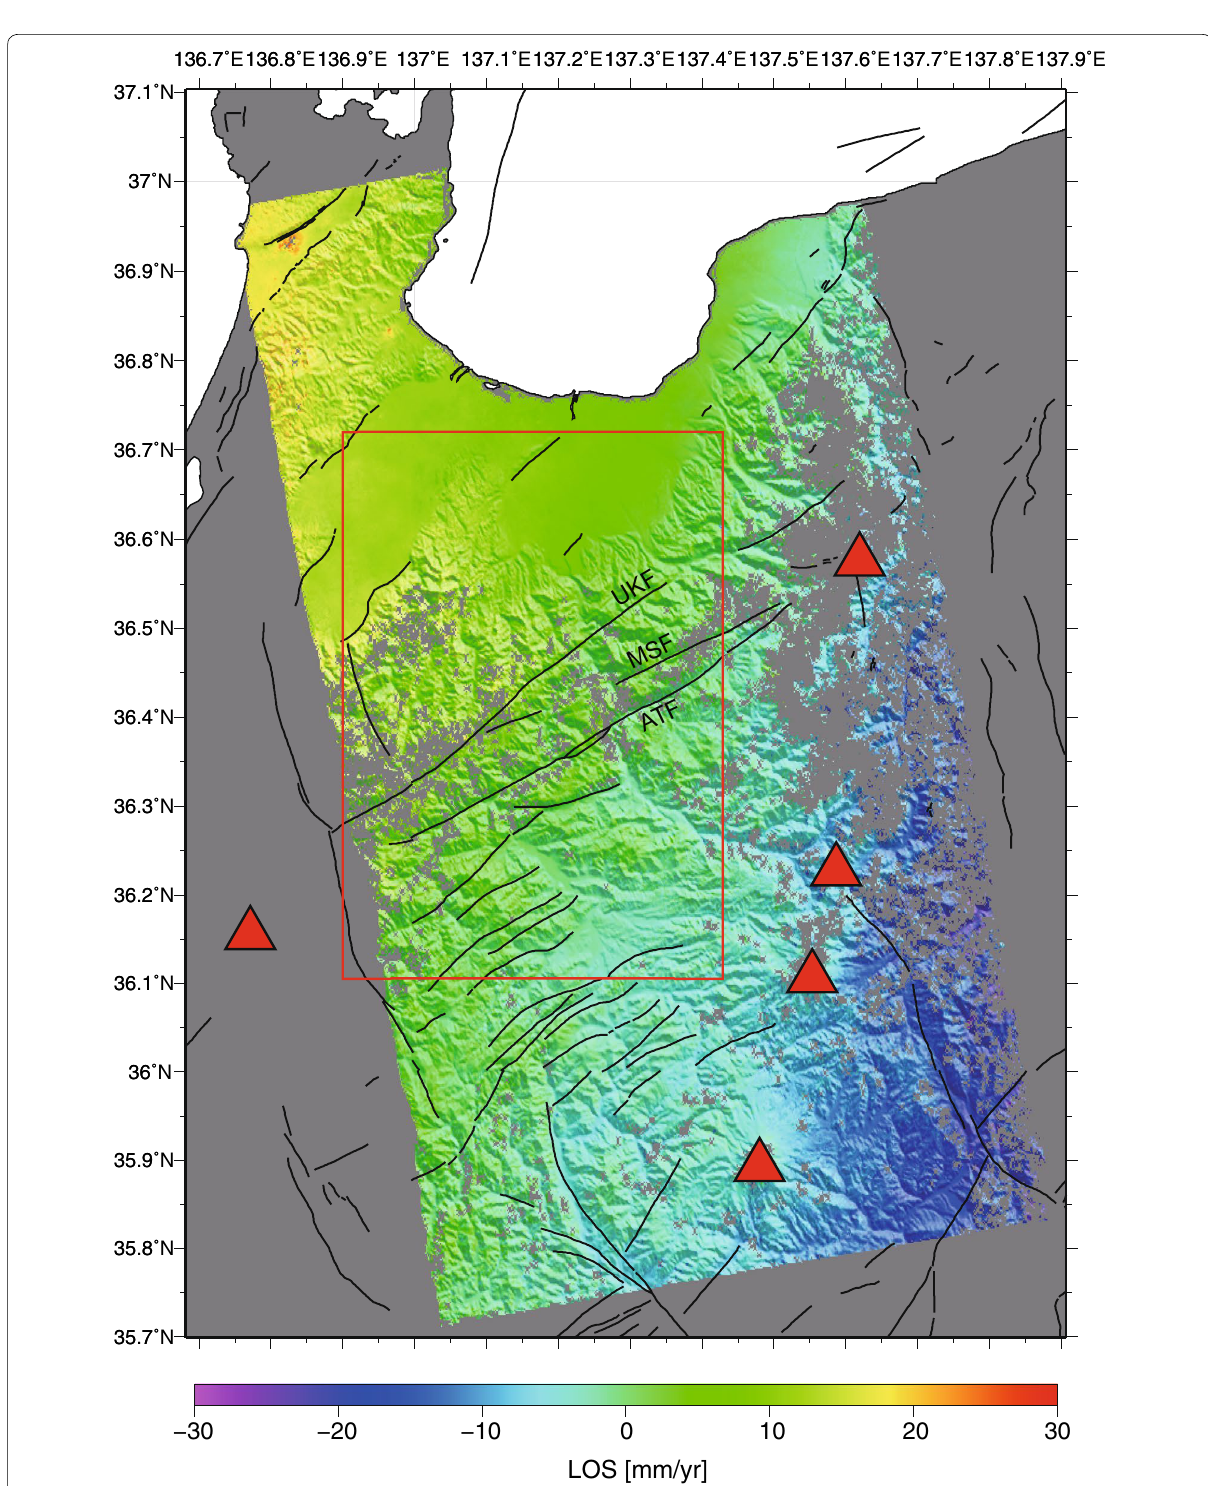
Fig. 3 Mean velocity field in and around the Atotsugawa fault system calculated using the InSAR time-series analysis. Note that color scale ranges from 30 to 30 mm/yr. The red frame indicates the area shown in Figs. 5 and 7. Triangles indicate active volcanoes. Black lines represent active −